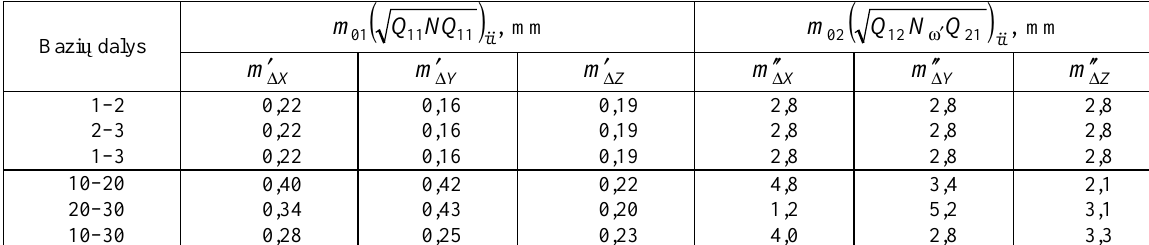
Table 2. Diagonal members of covariance matrix